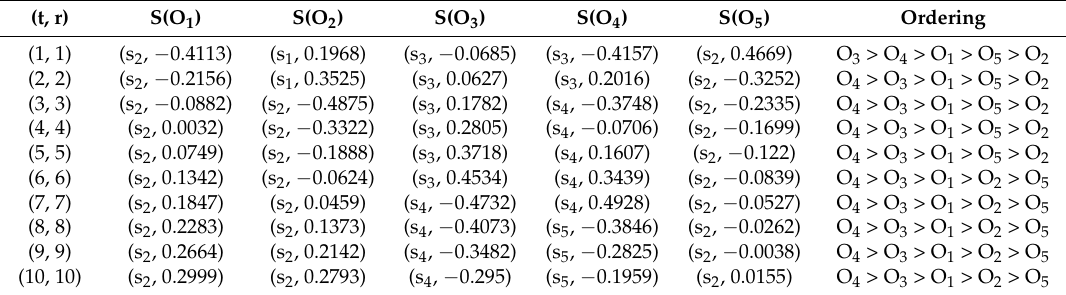
Table 5. Ranking results for different operational parameters of the GP2TLWBM operator.